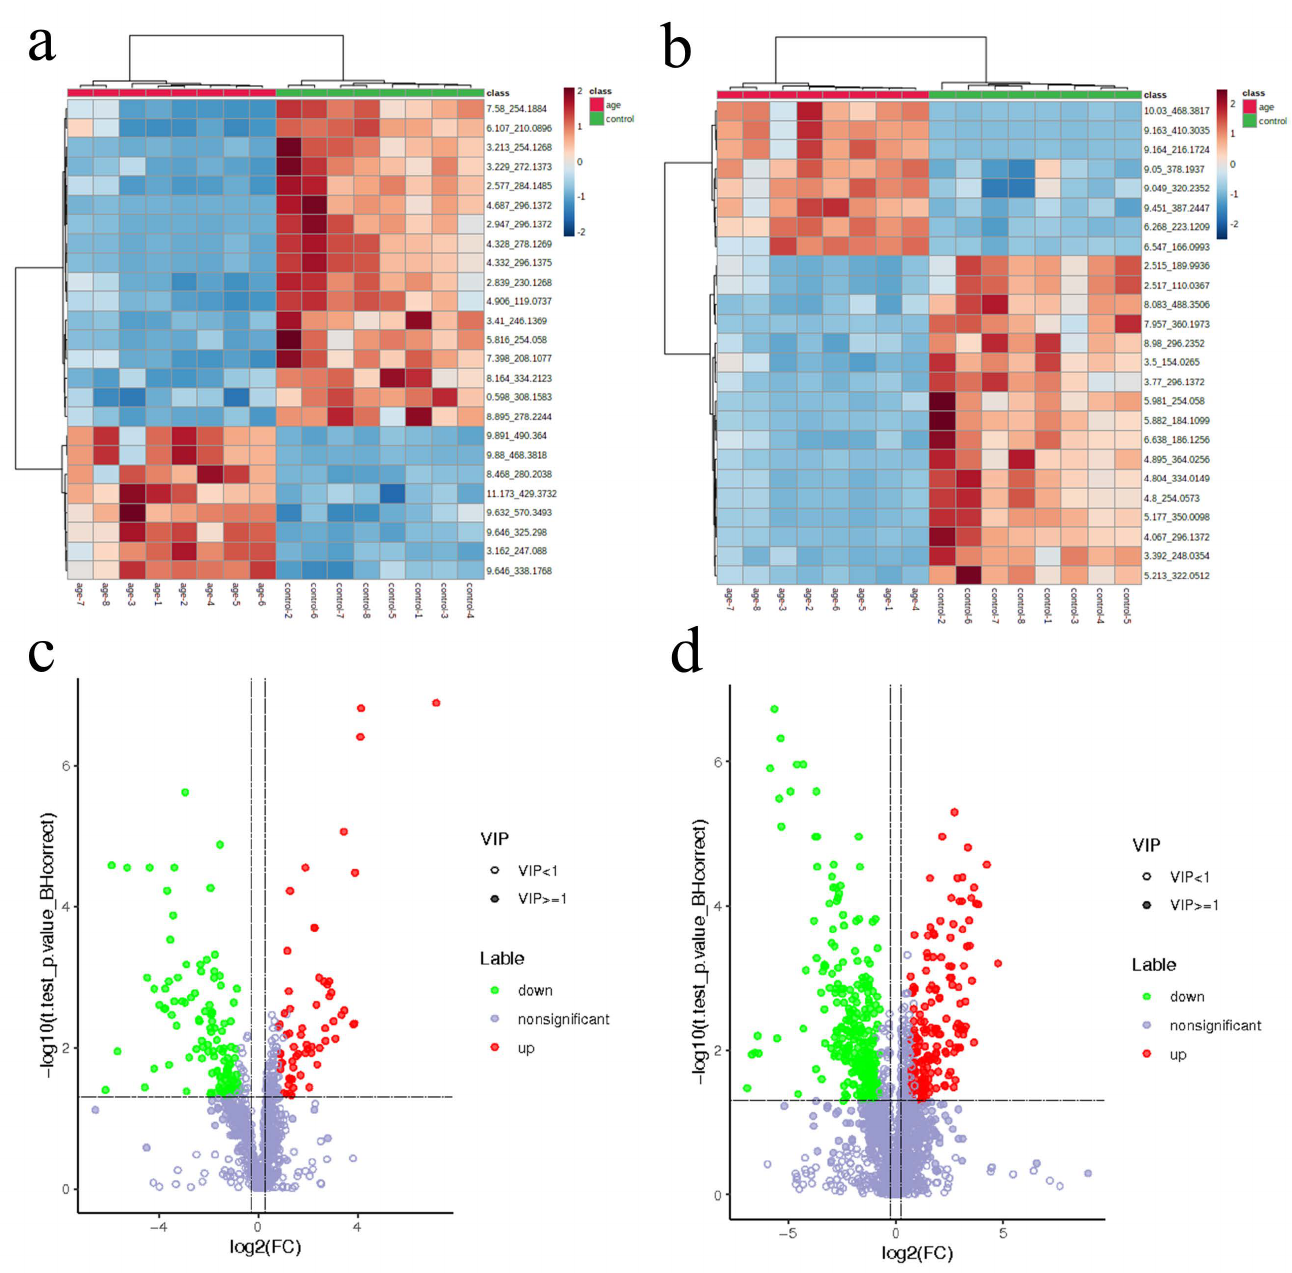
Figure 3. Altered serum metabolomics in the aging group compared with the control. ( a , b ) The heatmap of untargeted plasma metabolomics showing the top 20 metabolites that are different between the aging and control group; ( c , d ) The volcano plots of the different metabolic characteristics in the two modes. (( a , c ): neg; ( b , d ):